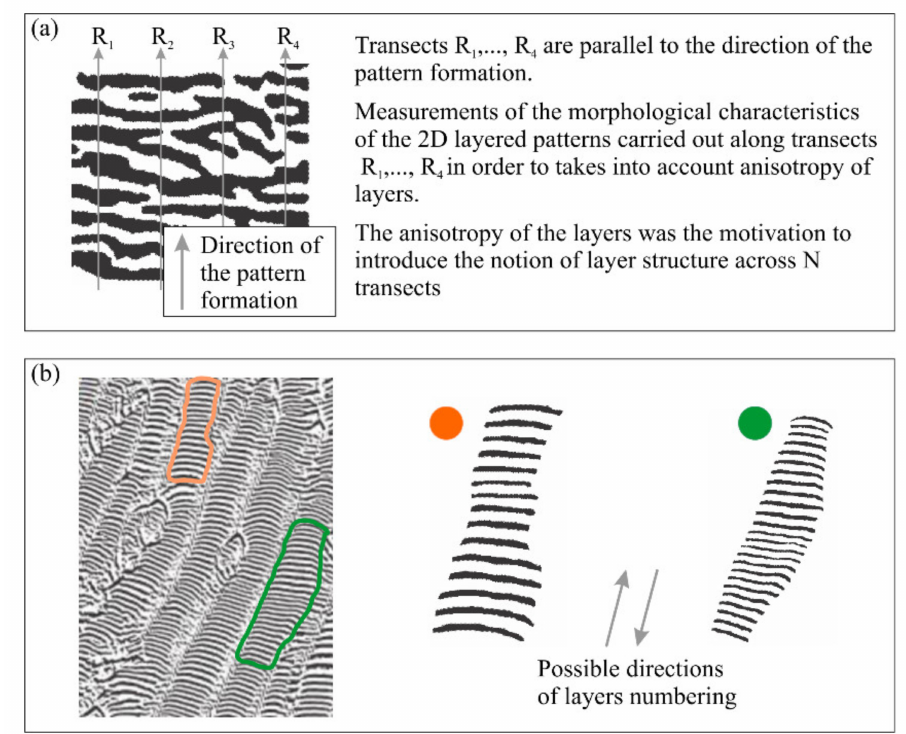
Figure 1. Two categories of layered pattern structures. ( a ) Human bone as a pattern with a layered anisotropic structure. ( b ) Mars’ surface in orange and green as a pattern with a layered isotropic structure. Credit: NASA